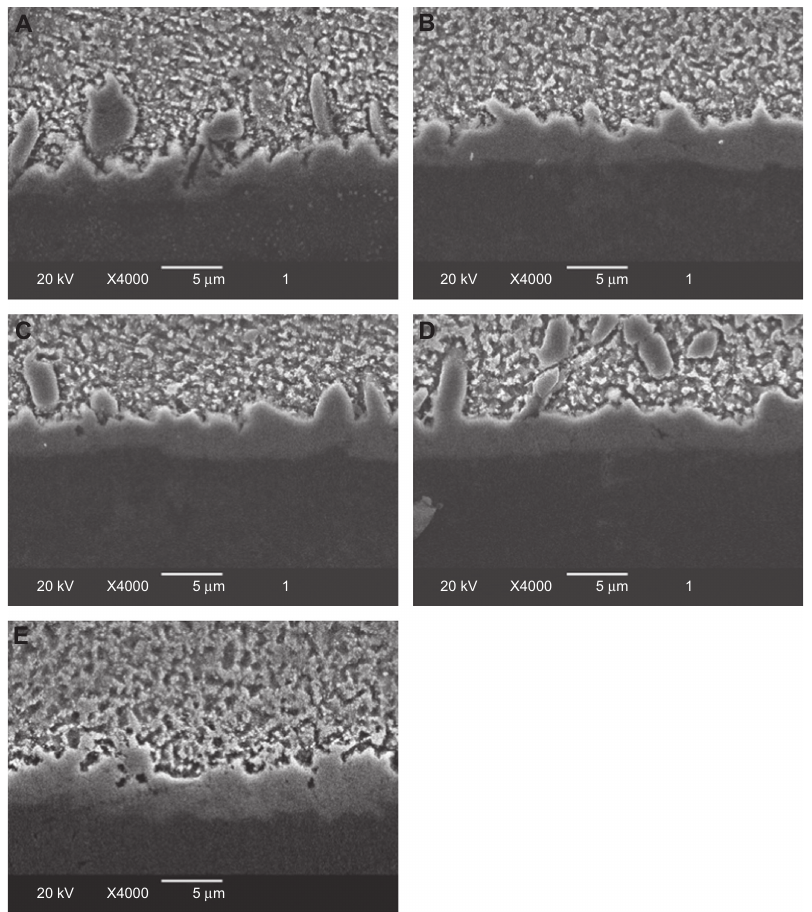
Figure 6 SEM micrographs of the interfacial IMC formed at 250 ° C for 50 h. (A) SAC305, (B) SAC305 – 0.05 vol% MWCNT, (C) SAC305 – 0.1 vol% MWCNT, (D) SAC305 SAC305 – 0.5 vol% MWCNT, and (E) SAC305 SAC305 – 1.0 vol% MWCNT.